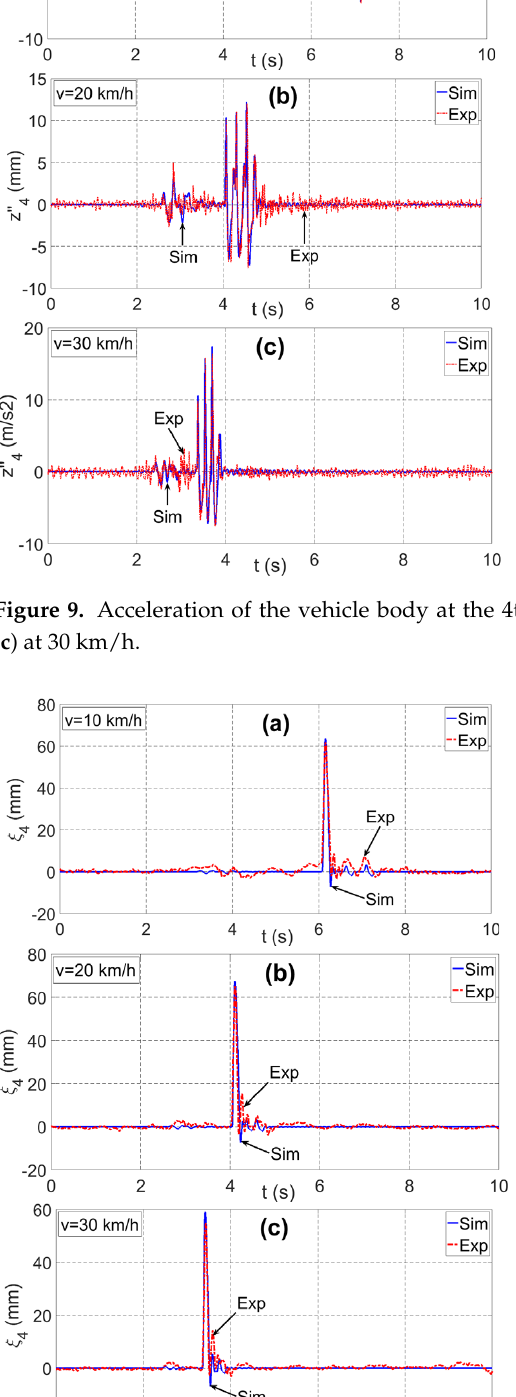
Figure 10. Displacement of the 4th axle (ξ 4 ): ( a ) at 10 km/h, ( b ) at 20 km/h, ( c ) at 30 km/h .